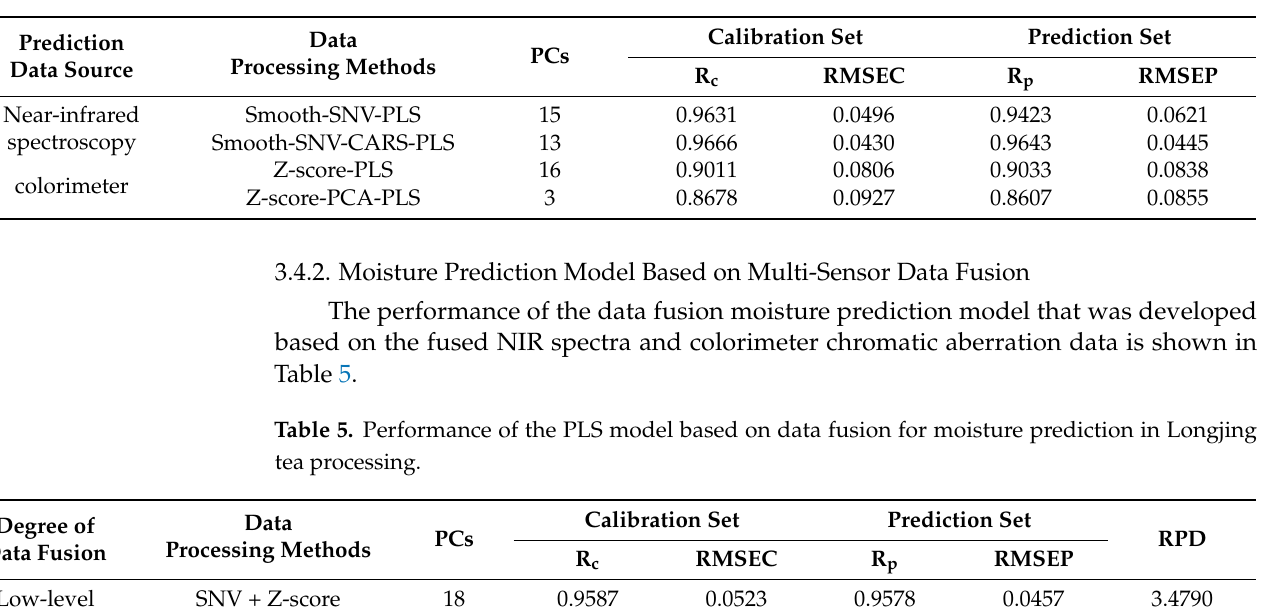
Table 4. Effect of a single NIR spectrum or colorimeter data on the accuracy of the PLS moisture prediction model.